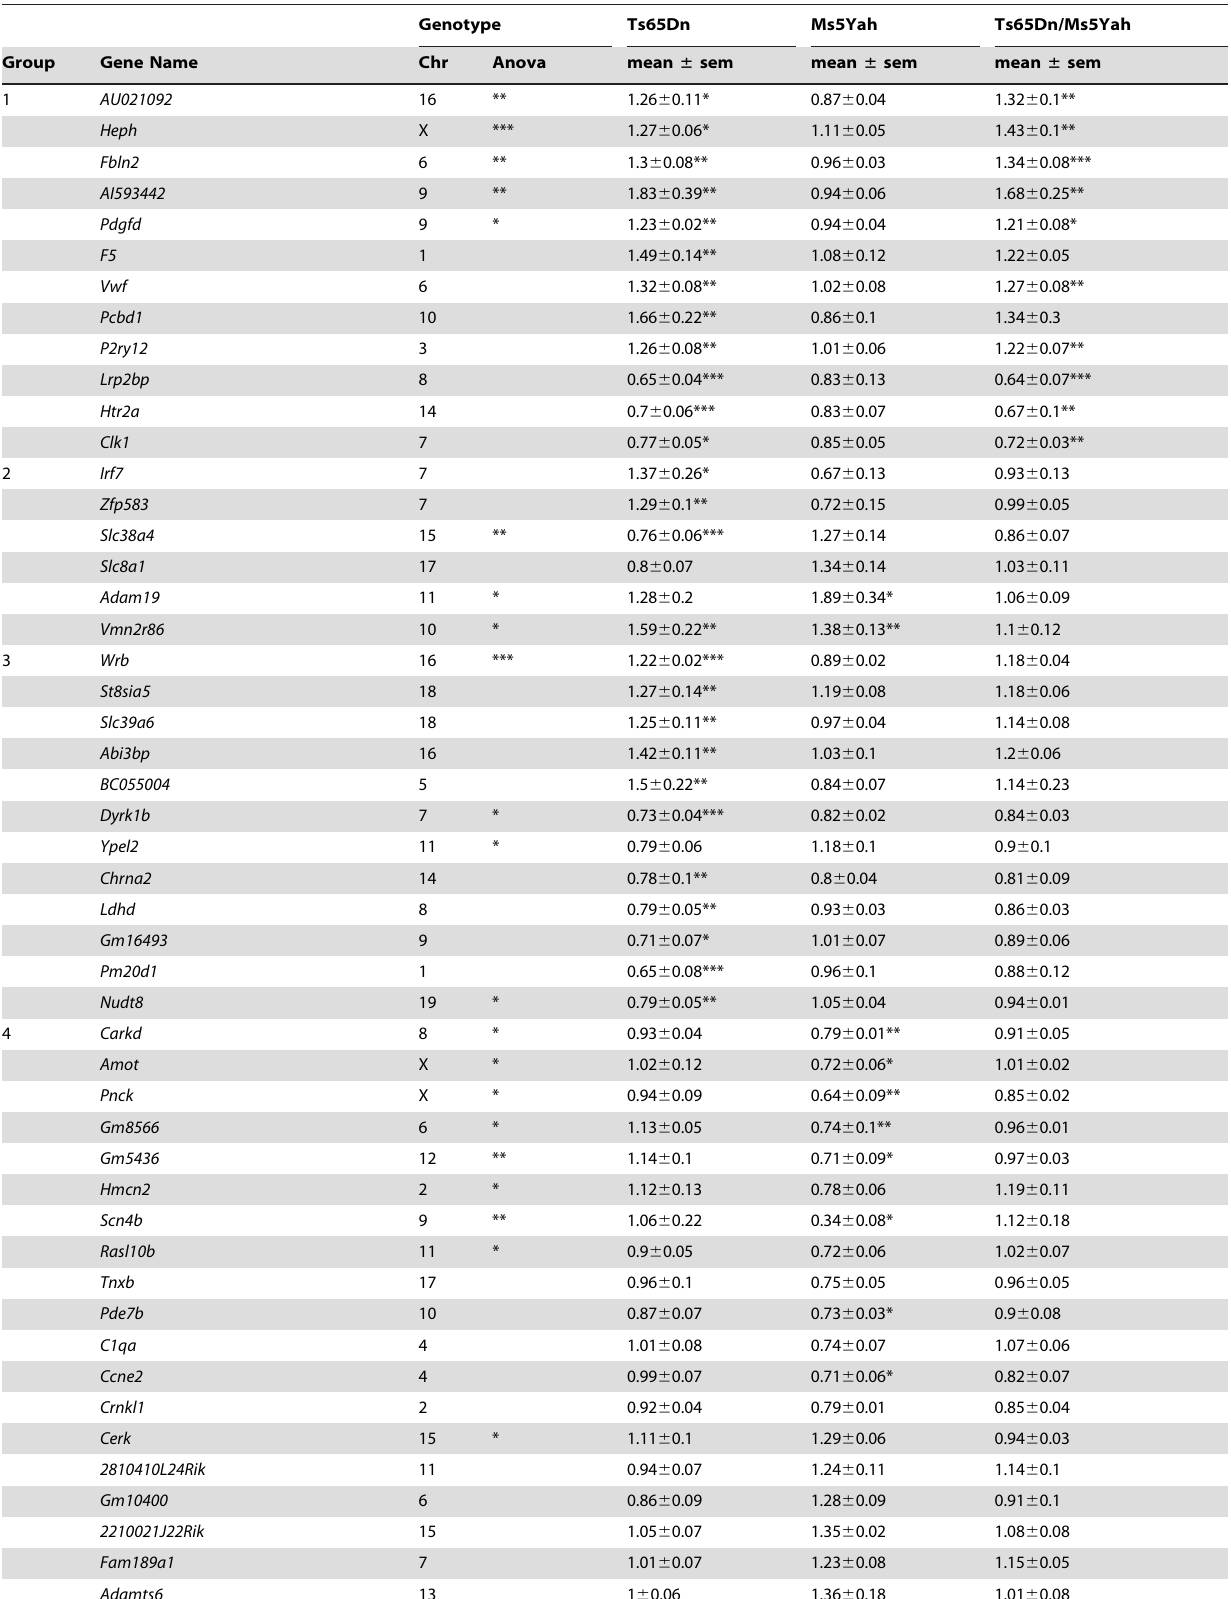
Table 6. Genes deregulated in the heart of Ts65Dn, Ms5Yah, and Ts65Dn/Ms5Yah compound